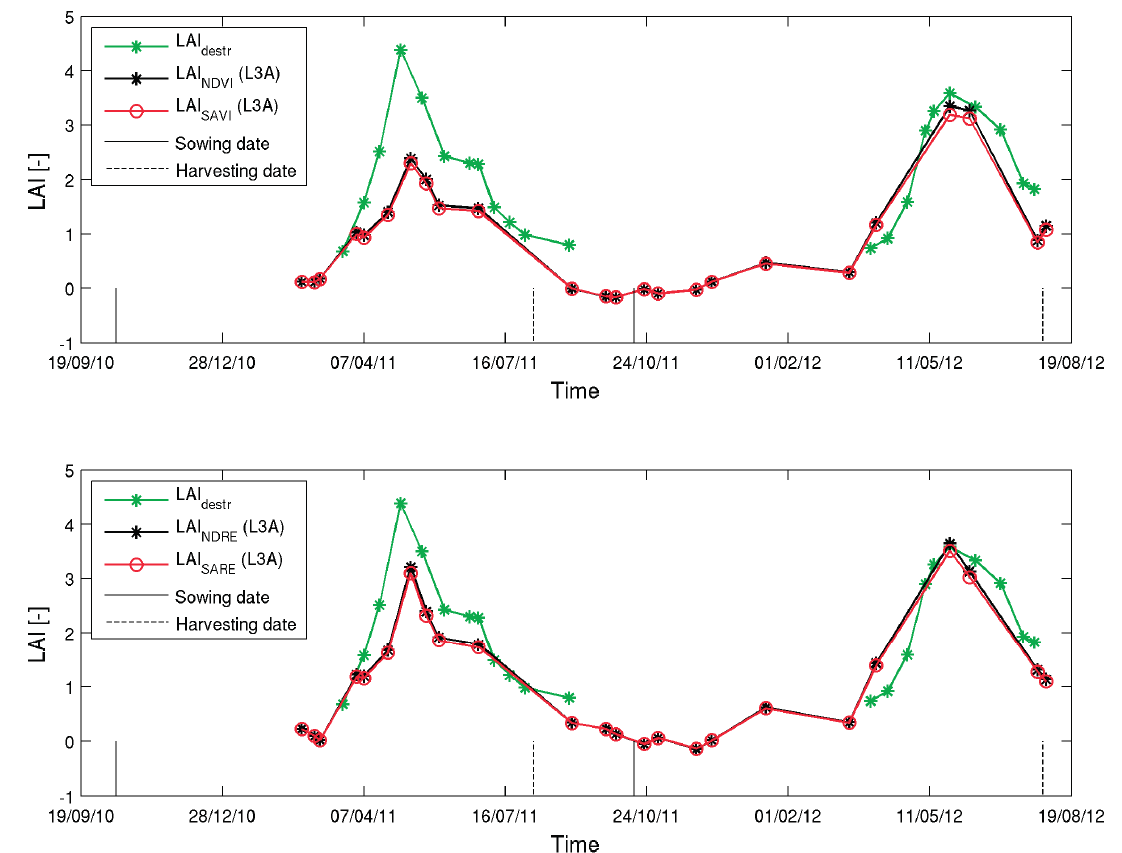
Figure 8. Temporal sequence of field-average destructive LAI destr with remote sensing based LAI NDVI and LAI SAVI (upper) and LAI NDRE and LAI SARE